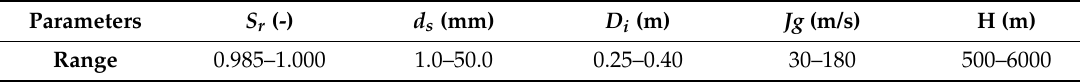
Table 1. The parameters of the airlifting system in DSM.